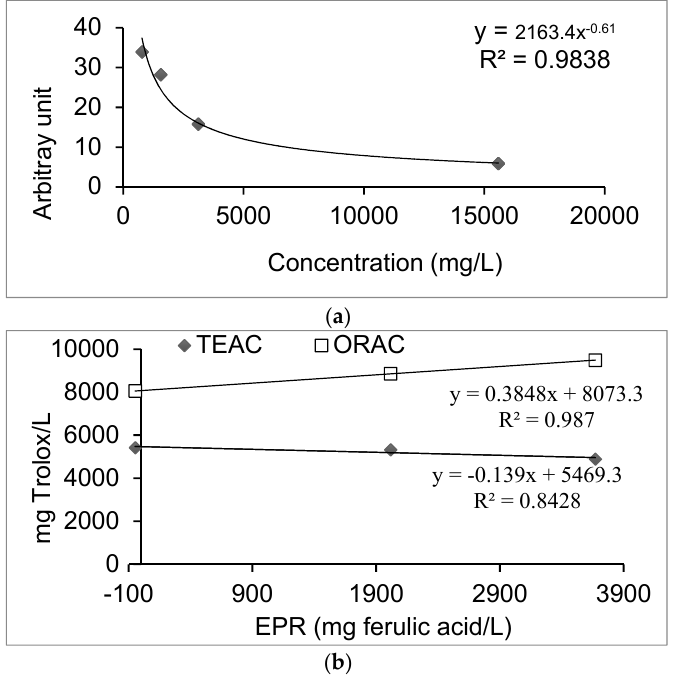
Figure 2. ( a ) Antioxidant activity determined by the electron paramagnetic resonance (EPR) assay for the CD ( Caesalpinia decapetala ) extract at different concentrations and ( b ) the correlation between the ORAC (oxygen radical absorbance capacity) and TEAC (trolox equivalent antioxidant capacity) assays with the EPR assay.